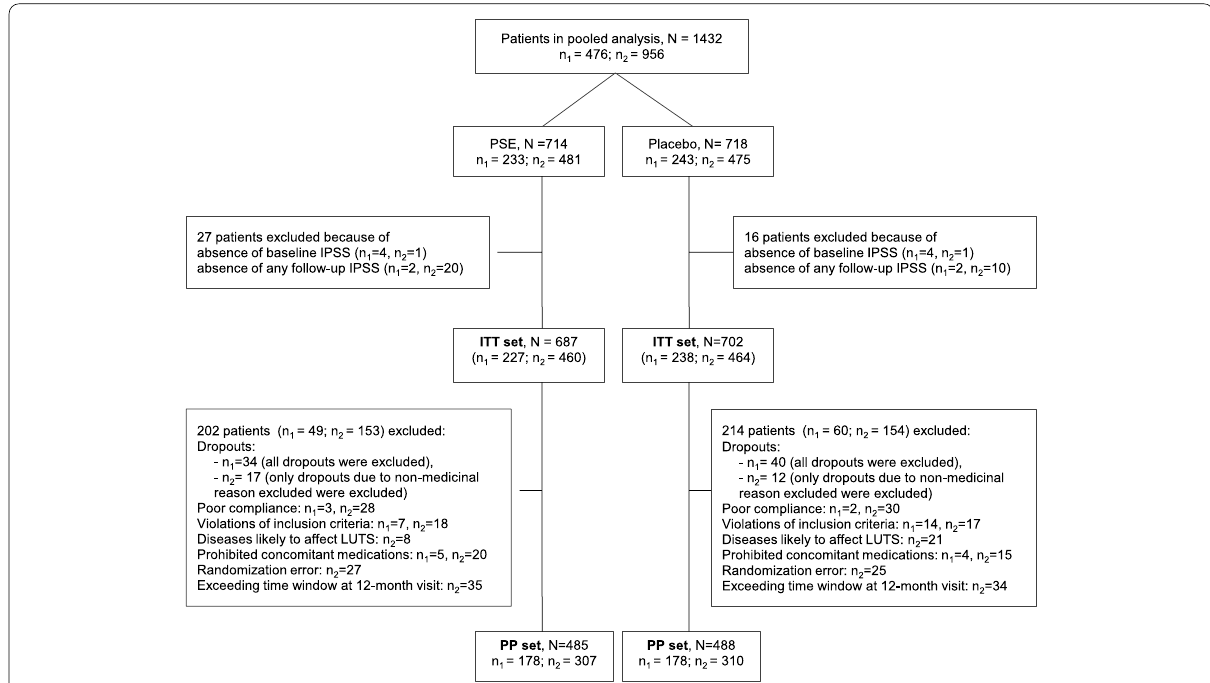
Fig. 1 Patient disposition. Number of patients: N, pooled; n 1 , Bach study; n 2 , GRANU study. PSE pumpkin seed soft